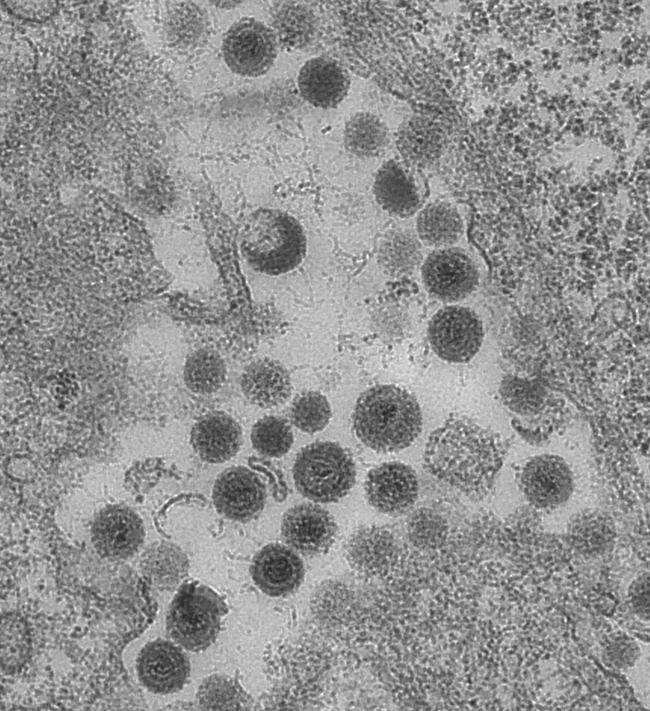
MHV-68 virions emerging from infected cells